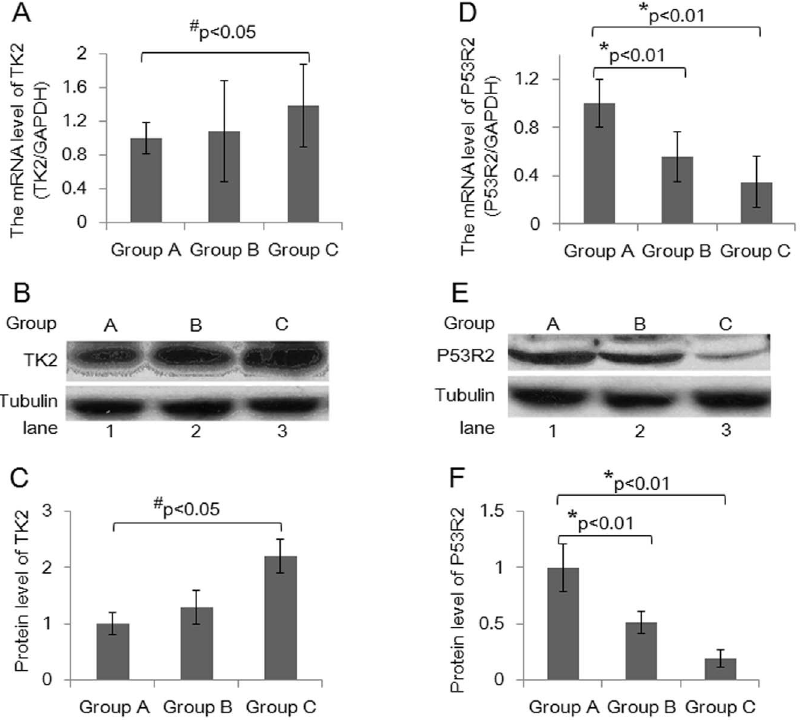
Figure 3. Long-term treatment with NRTIs can induce TK2 overexpression and reduce P53R2 expression in PBMCs. A: TK2 mRNA expression was quantified by qRT-PCR in control children (Group A, n=50), children with AIDS treated for less than 36 months (Group B, n=68) and children with AIDS treated for 36 to 72 months (Group C, n=84); # P , 0.05. B: Western blot of TK protein expression in Group A, Group B and Group C. C: The graphics from 3B are shown in 3C. Data from triplicate independent experiments are presented as the mean 6 SD. # P , 0.05. D: P53R2 mRNA expression was quantified by qRT-PCR in control children (Group A, n=50), children with AIDS treated for less than 36 months (Group B, n=68) and children with AIDS treated for 36 to 72 months (Group C, n=84); *P , 0.01. E: Western blot of P53R2 protein expression in group A, group B and group C. F: The graphics from 4B are shown in 4C. Data from triplicate independent experiments are presented as the mean 6 SD. *P , 0.01.